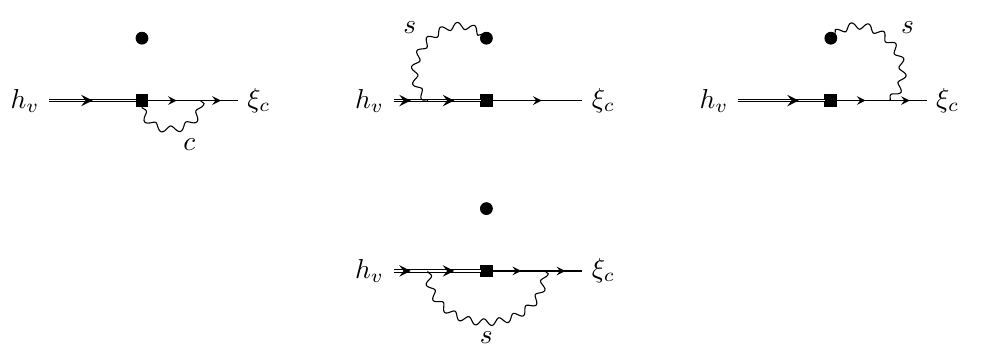
Figure 5 . Diagrams at O ( α em ) that contribute to the renormalization of the operator (3.19). The black dot denotes the Wilson line operator S † ( Q M 2 ) n